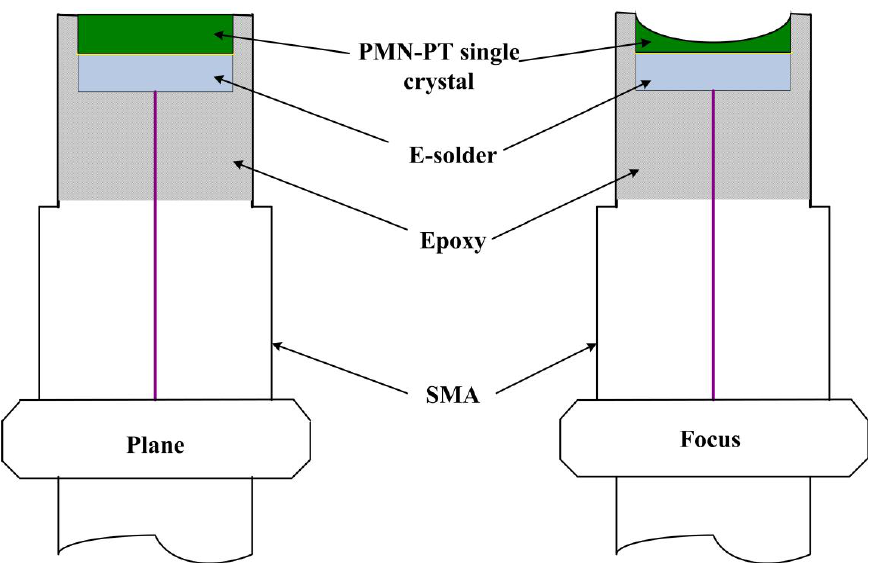
Figure 9. A schematic diagram of the plane and focusing transducers (with permission from